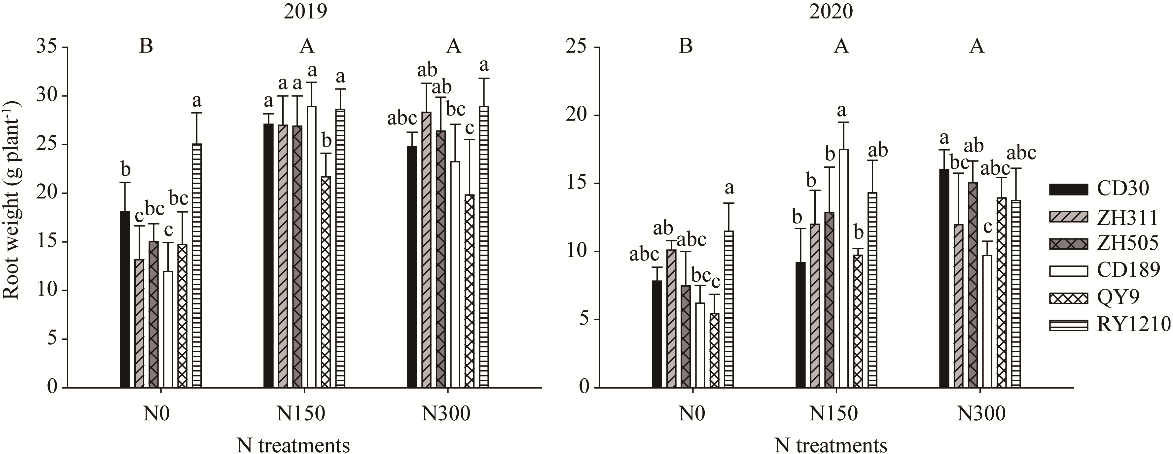
Figure 3. Root biomass of six maize cultivars under three N treatments in 2019 and 2020. Bars indicate